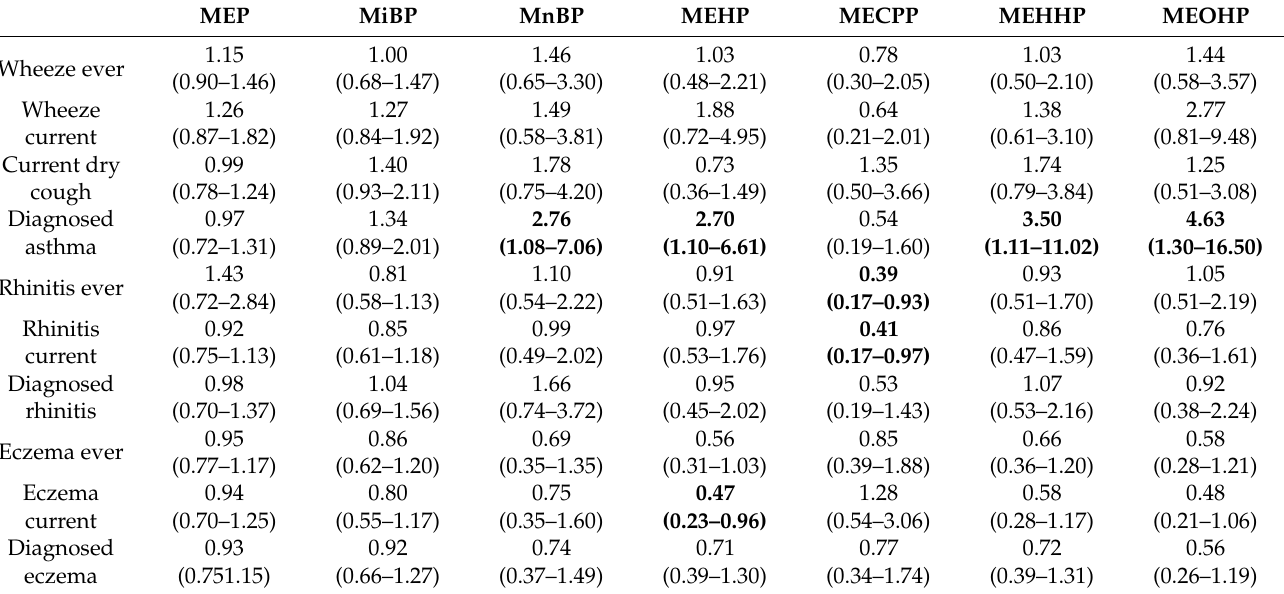
Table 5. Associations [AOR (95% CI)] between urinary phthalate metabolite concentrations and allergic symptoms in boys ( n =